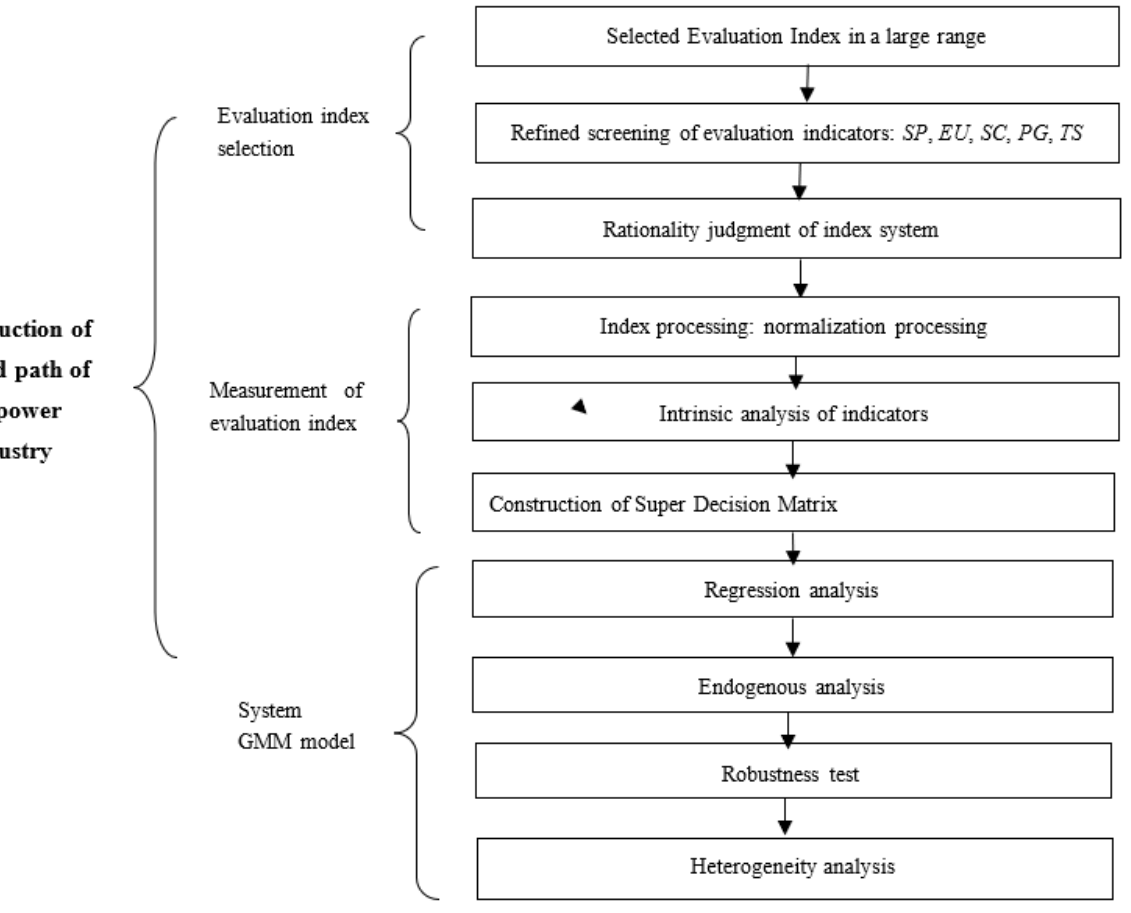
Figure 1. A Flowchart of the Experiment.